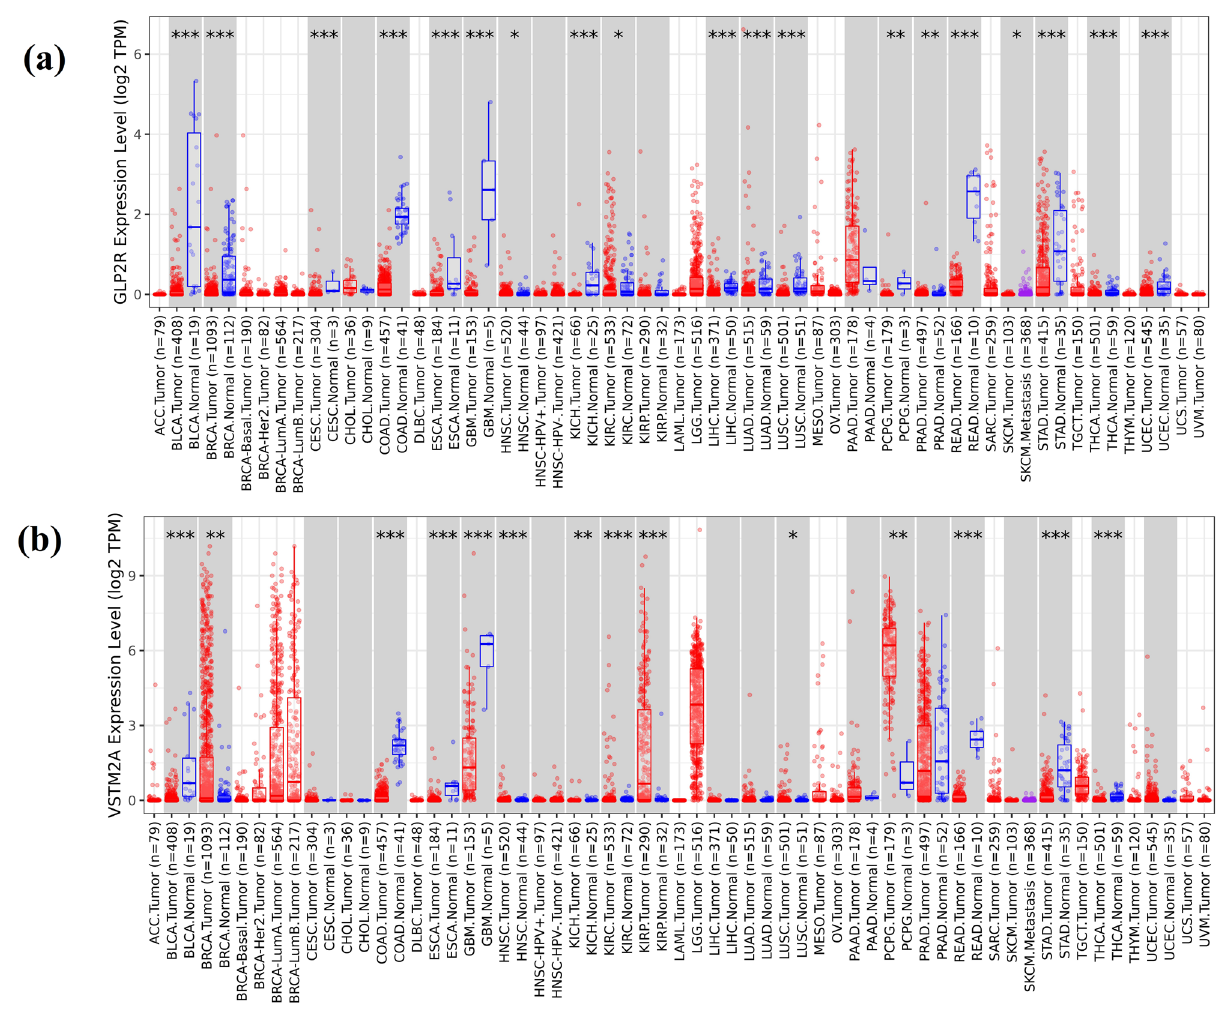
Figure 6. The expression of final set of genes (GLP2R and VSTM2A) in tumor and normal tissue, where red box plots and blue box plots suggests tumor tissues and normal tissues across different cancer types respectively. “***” indicated P <